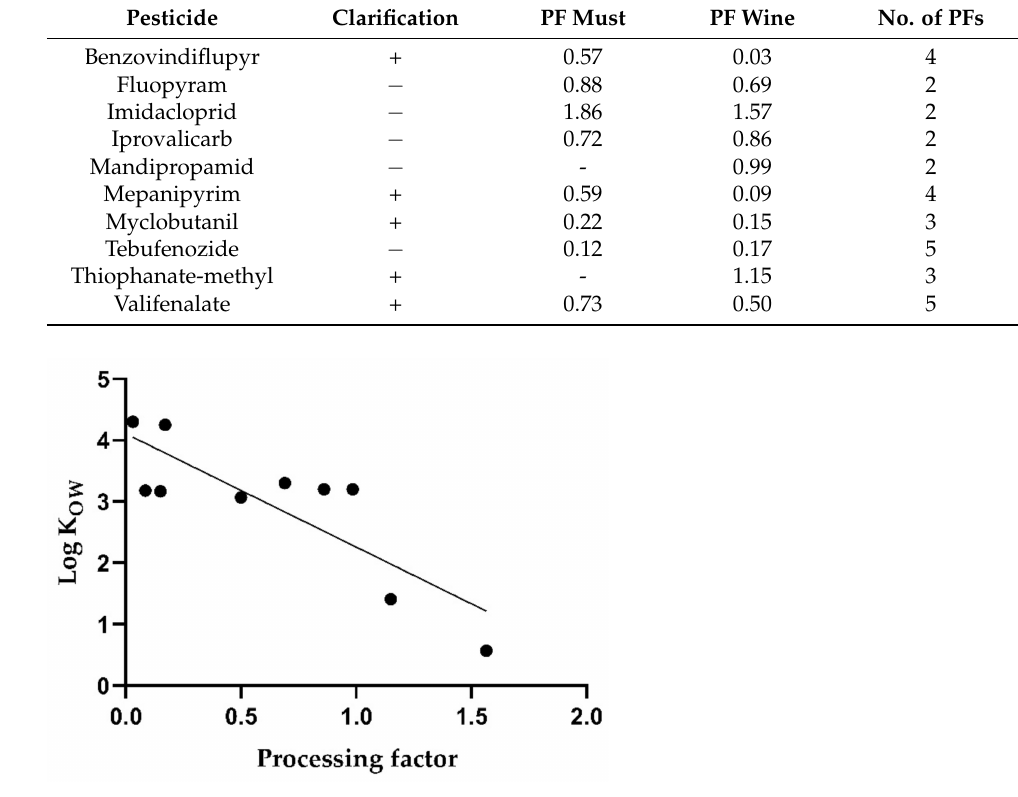
Table 2. Median processing factors (PF) for different pesticides in clarified (+) and non-clarified ( − ) white wine.